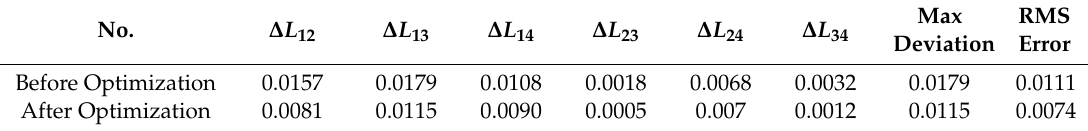
Table 6. Distance errors between global control points with angle optimization (unit: mm).